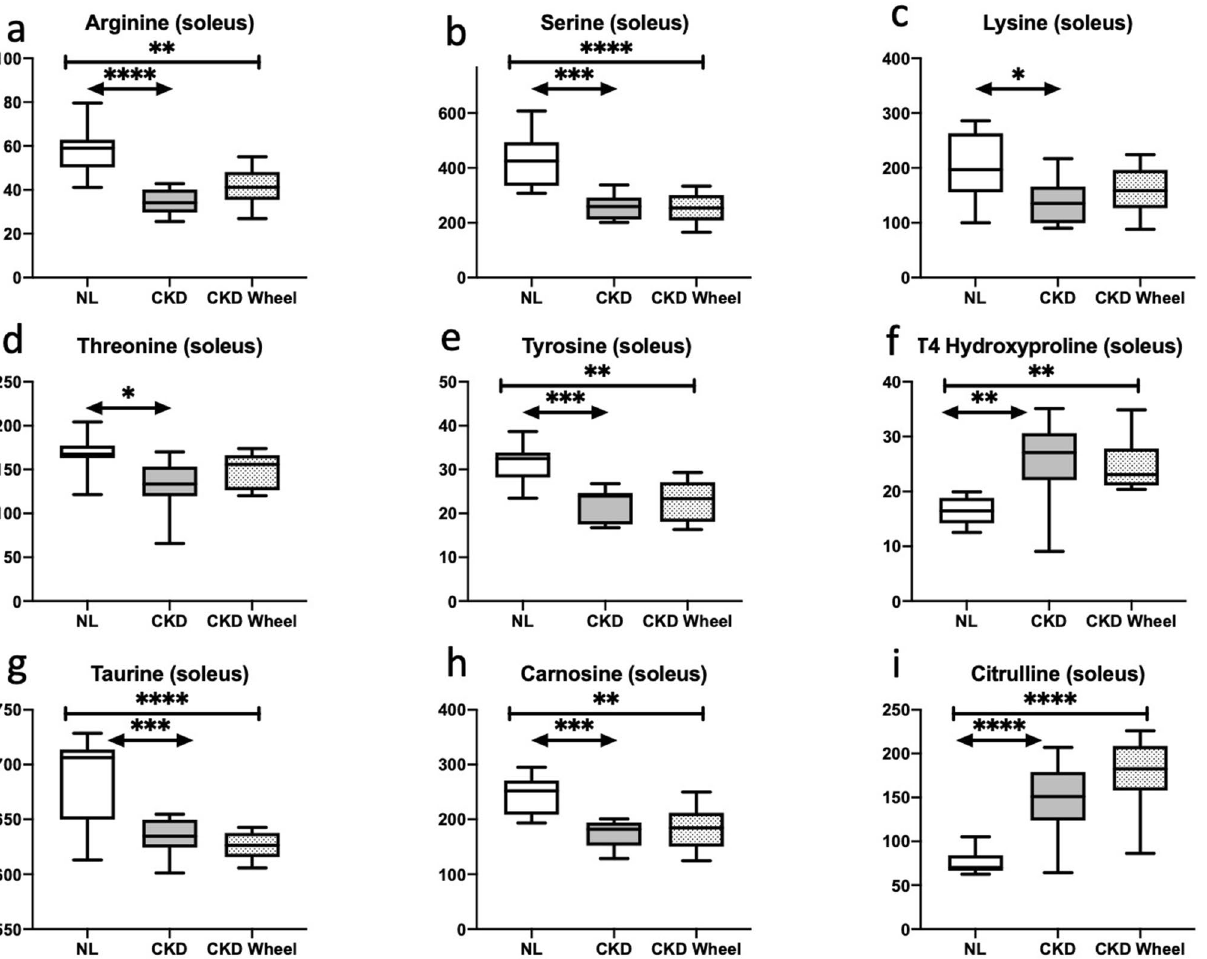
Figure 2. The soleus demonstrated differences in nine amino acid-related compounds. ( a – e ) The five standard amino acids (i.e. arginine, serine, lysine, threonine, tyrosine) were reduced. ( f ) The modified amino acid, 4-hydroxyproline was increased in the CKD and CKD-W as compared to NL rats. ( g – i ) Taurine and carnosine were reduced while and citrulline was increased in CKD and CKD-W as compared to NL. Data are shown as mean ± SD (n = 9–12 rats each group). * p < 0.05, ** p < 0.01, *** p < 0.001. ⎴ (NL vs. CKD comparison); ← → (NL vs. CKD-W comparison); l—l (CKD vs. CKD-W